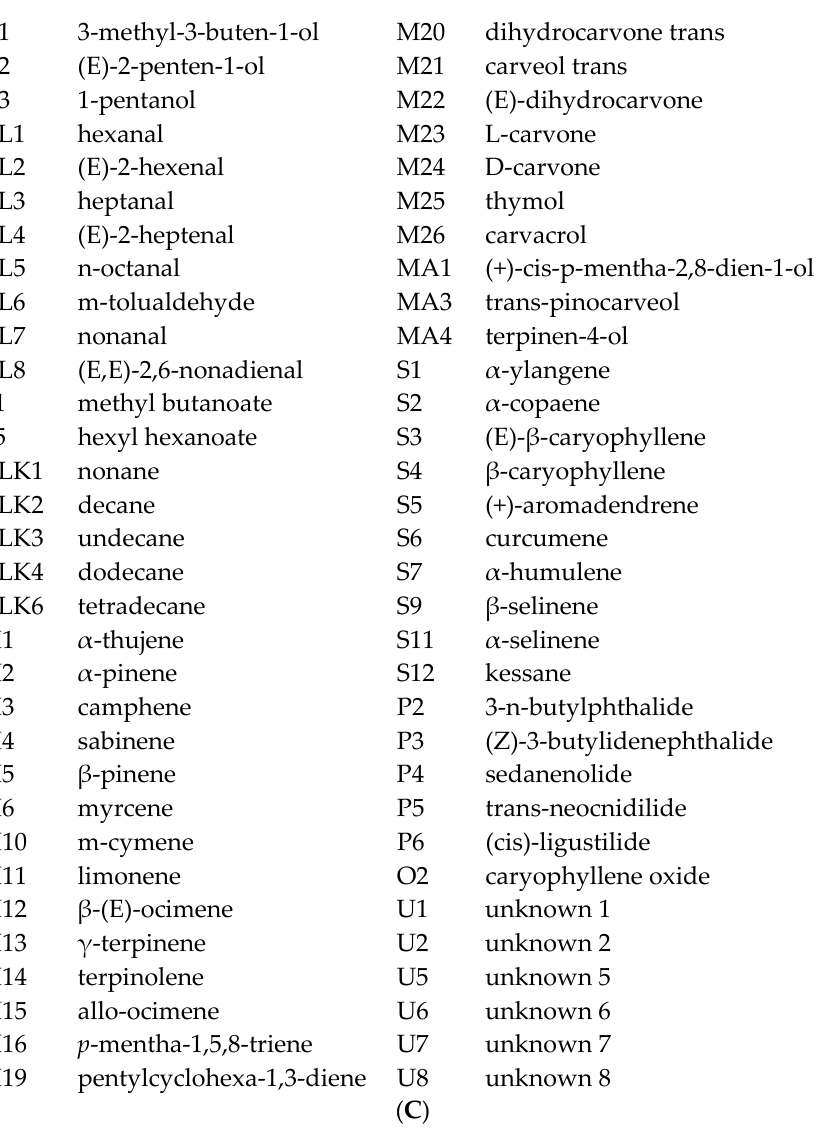
Figure 2. Principal component analysis of eight celery samples harvested in 2018 showing correlations with volatile compounds and sensory attributes. ( A ) Projection of the samples; ( B ) Distribution of variables; ( C ) Compound codes as they appear in plot ( B ).